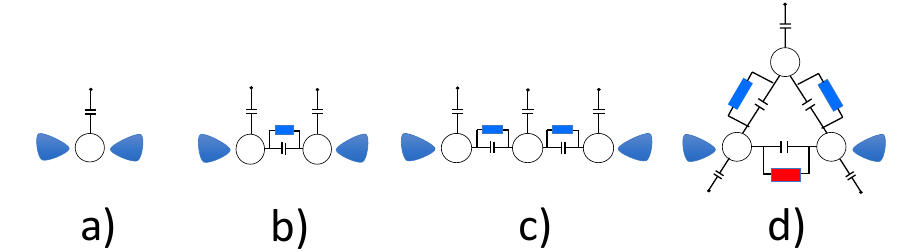
Figure 2: Experimental realization of the Keldysh model in quantum dots: a) single QD; b) serial double QD; c) linear (serial) triple QD; d) triangular triple QD.